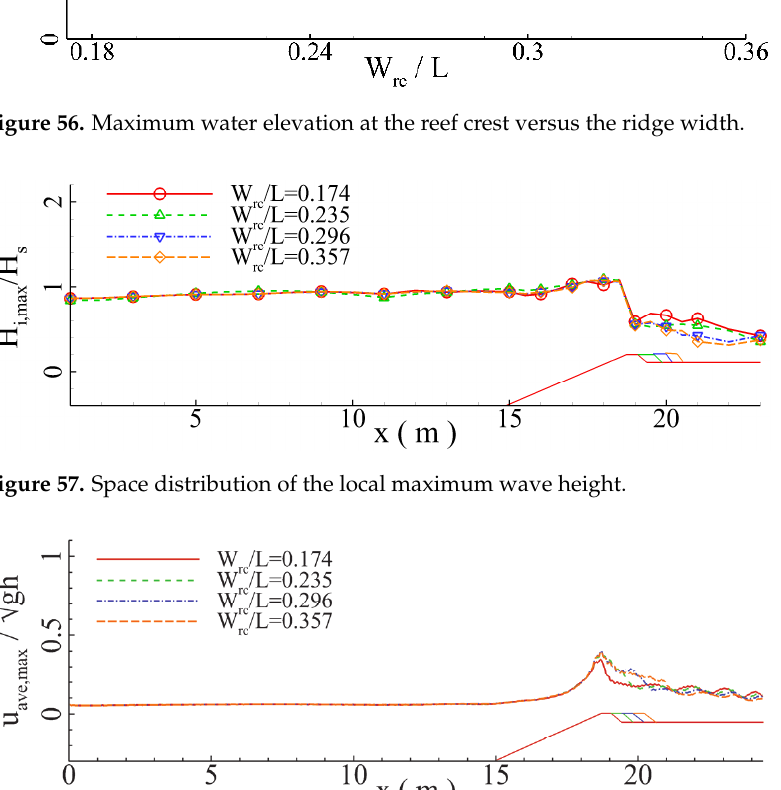
Figure 59. Maximum depth-averaged velocity at the reef crest versus the ridge width.